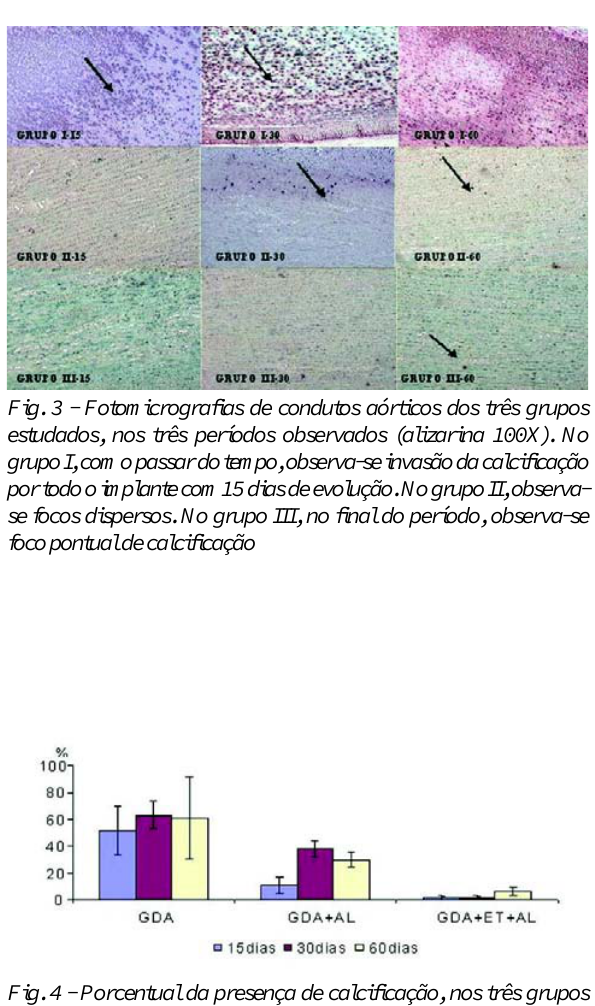
Fig. 4 - Porcentual da presença de calcificação, nos três grupos estudados, ao longo do tempo: análise morfométrica